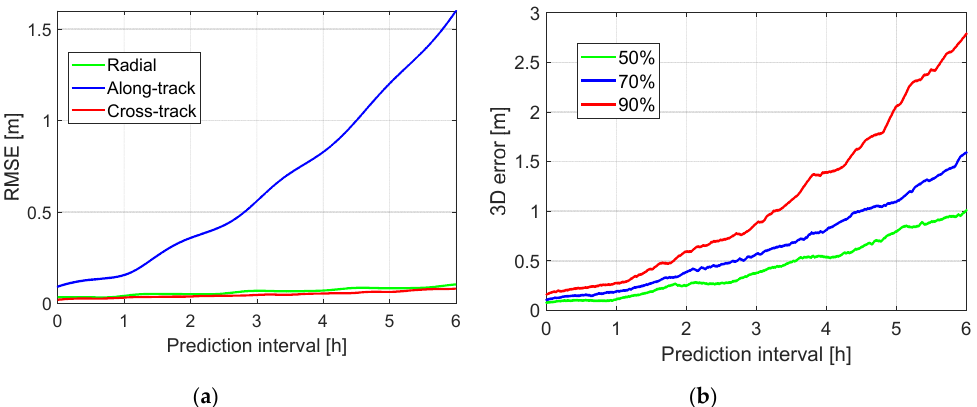
Figure 9. ( a ) RMSE of the predicted orbits in the radial, along-track and cross-track directions and ( b ) the 50%, 70% and 90% percentile lines of the 3D prediction errors. The dynamic model used applies stochastic velocity pulses set up for every 2 h (Table 2).